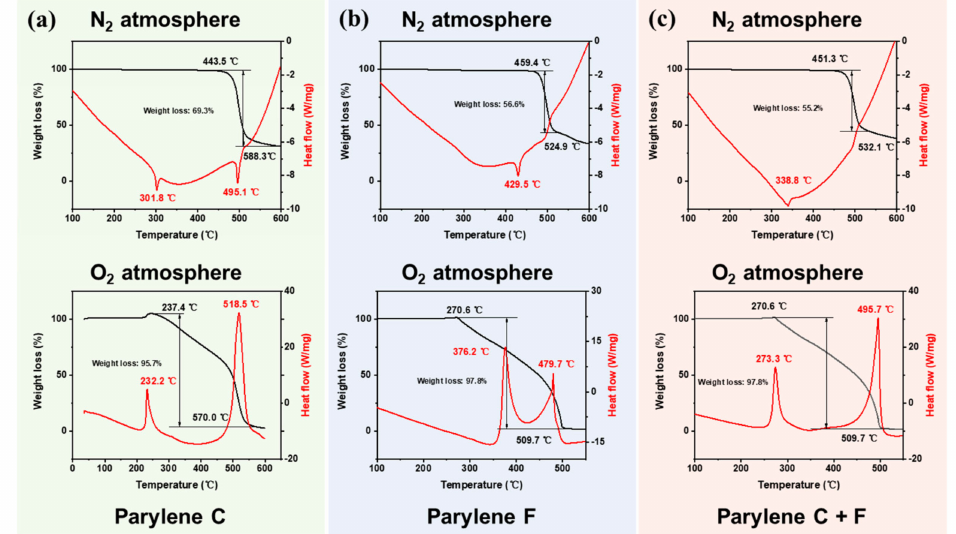
Figure 5. Comparison of the Parylene homopolymer and copolymer films in thermal stability by TGA tests in N 2 atmosphere and O 2 atmosphere: ( a ) Parylene C; ( b ) Parylene F; ( c ) Parylene CF. The Parylene copolymer method improved the thermal stability slightly for Parylene films in the N 2 atmosphere and significantly in the O 2